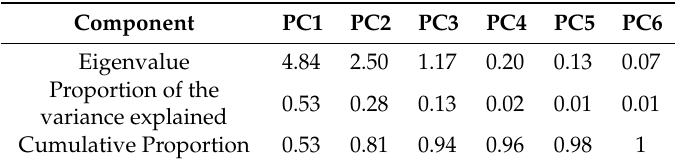
Figure 5. Mean (Inner Square), standard error (bar), 95% confident interval (whisker) of each of the variables in the environmental regions. From left to right, and top to bottom: precipitation (prec; mm); maximum temperature (tmax; ◦ C); minimum temperature (tmin; ◦ C); mean elevation (mean_elev; ma.s.l.); maximum elevation (max_elev; ma.s.l.); minimum elevation (min_elev; ma.s.l.); amount of days with below zero temperatures (days.below.zero.mean; days); vapor pressure (vapr; kPa); solar radiation (srad; kJ m − 2 day − 1 ). Table 1. Importance of components.